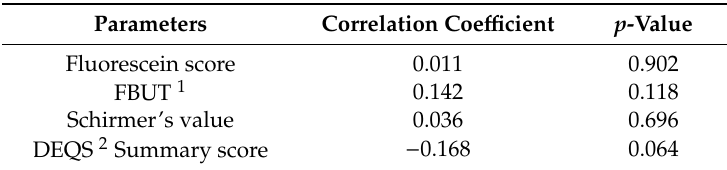
Table 2. Associations between tear osmolarity and other parameters.